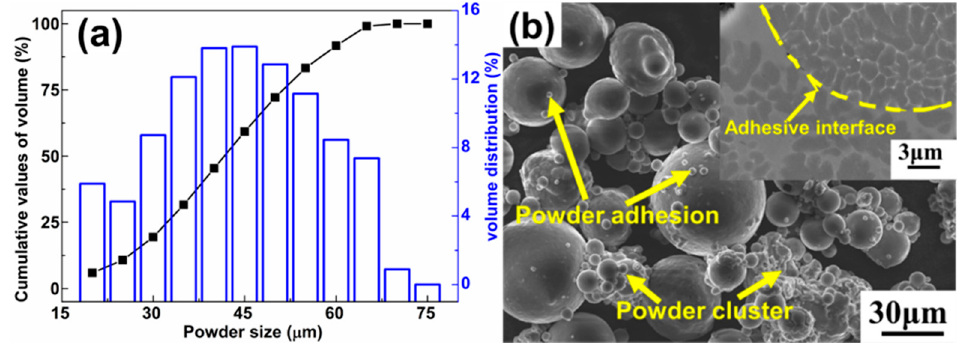
Figure 1. ( a ) Distribution of the powder size; ( b ) typical morphologies of the starting Al-3.5Cu-1.5Mg-1Si powders (inset: Cross-section of a powder particle).